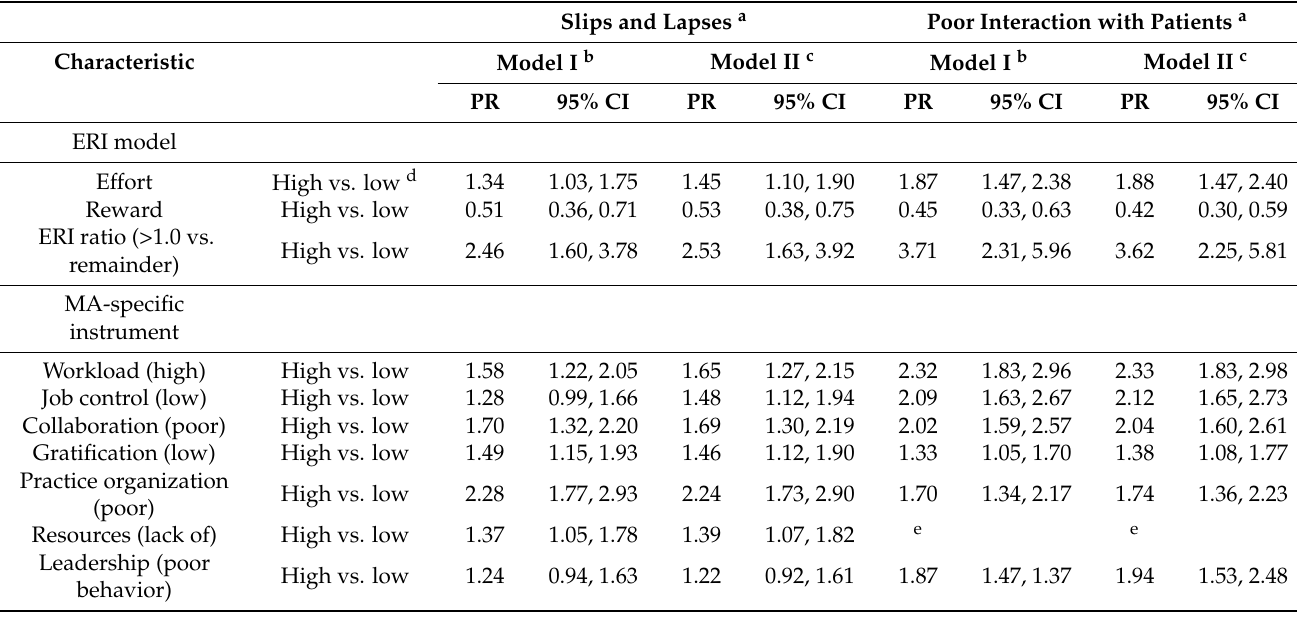
Table 3. Associations of psychosocial working conditions with slips and lapses or poor interaction with patients due to work stress among medical assistants (Poisson